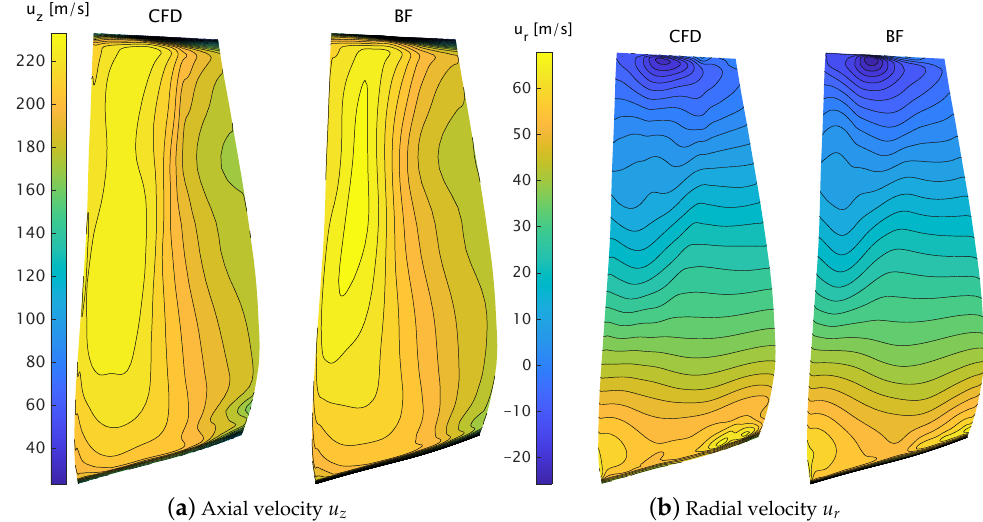
Figure 8. Velocity contours on the blade for reference CFD solution and baseline body force model at peak efficiency.